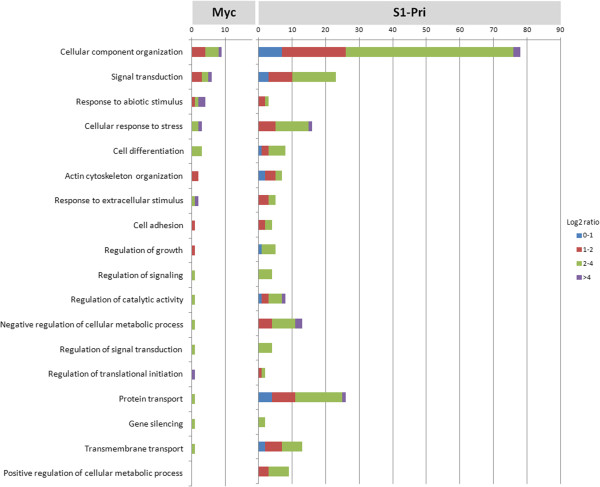
Assignment of DEGs to 18 selected Biological Process in Gene Ontology. Eighteen selected Biological Processes in Gene Ontology are presented to show that many biological processes such as cellular organization, signal transduction, environmental sensing, stress response, cellular process regulation and protein transport are significantly up-regulated in S1-Pri compared to Myc during fruiting body formation.